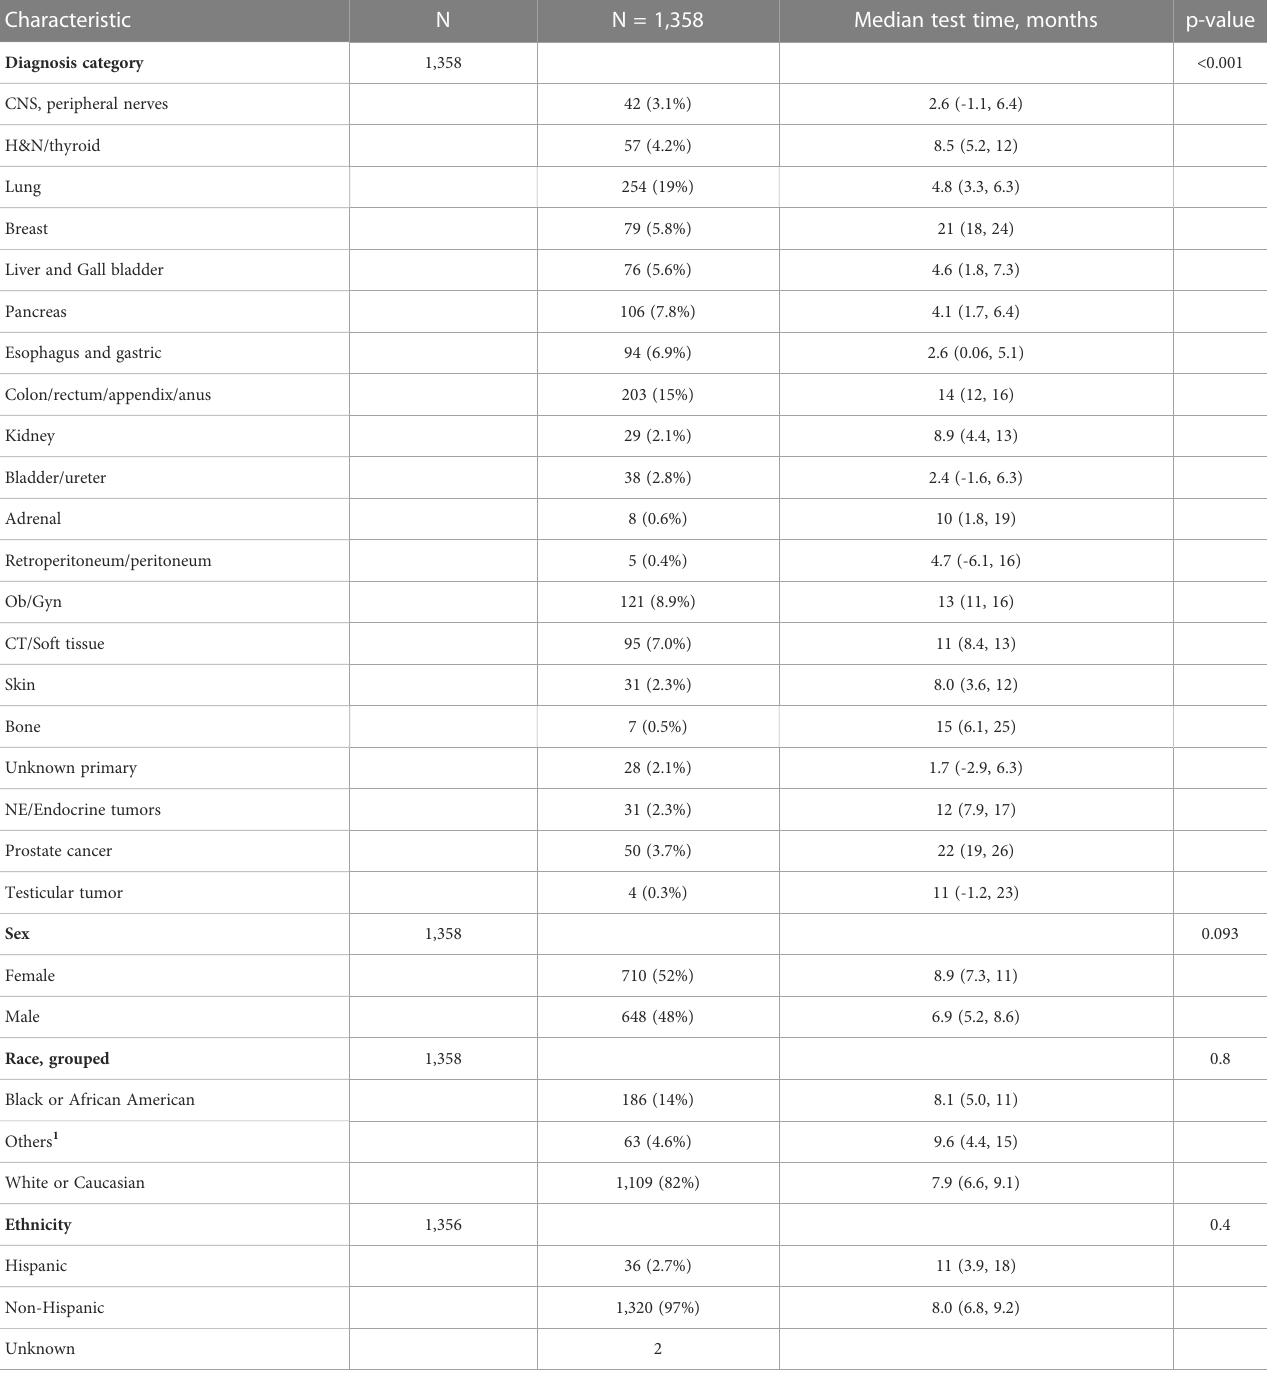
TABLE 1 Characteristics and median time between metastatic diagnosis and CGP test of entire cohort who underwent comprehensive genomic pro fi ling test after diagnosis of metastatic disease.